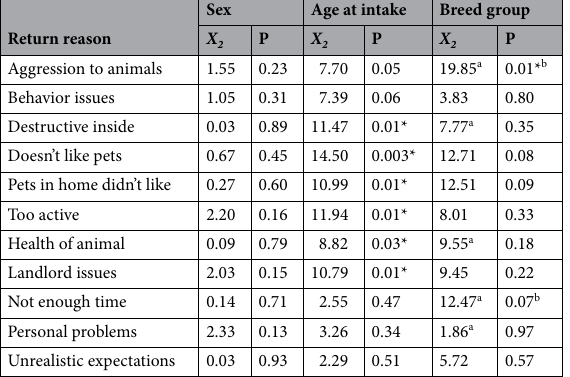
Table 4. Individual return reasons ( n > 50) by sex, age, and breed among dogs. *Denotes statistical significance ( p < 0.05). a Fisher–Freeman–Halton Exact Test due to > 20% of cells with an expected count below 5. b Monte Carlo approximation method used based on 10,000 sampled tables.